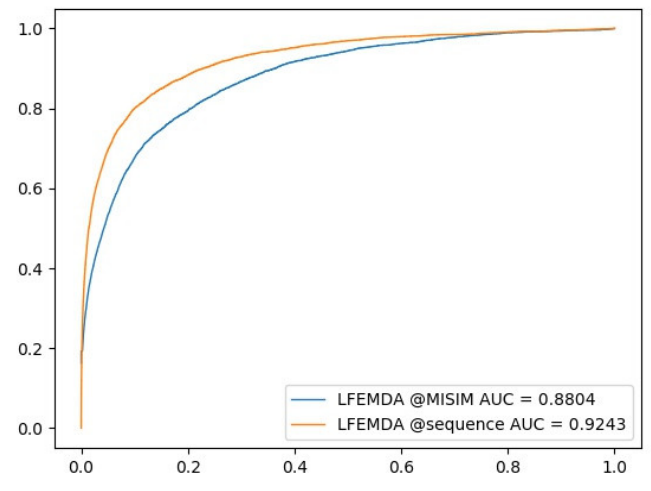
Figure 2. LFEMDA with different miRNA functional similarity